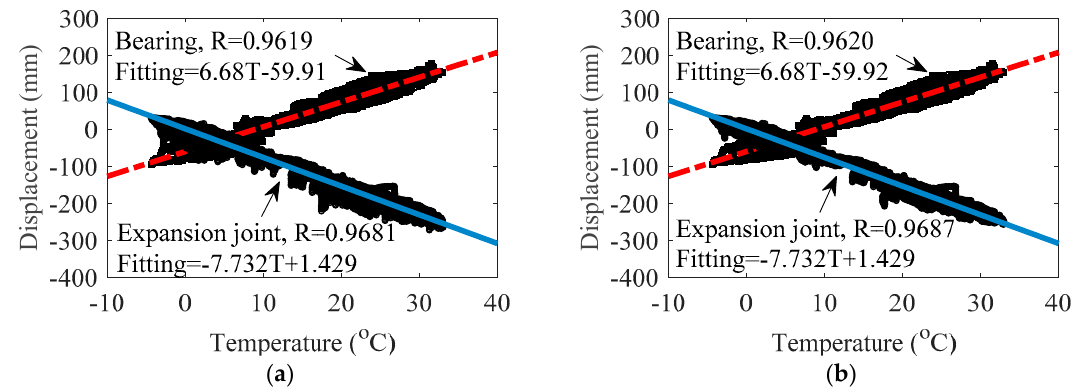
Figure 8. Correlation between longitudinal displacement and atmospheric temperature at the south girder end (bearing (B-7-11) and expansion joint (EJ-7-1)) from June to December in 2017: ( a ) original longitudinal displacement data; ( b ) first decomposition part of the EWT results.